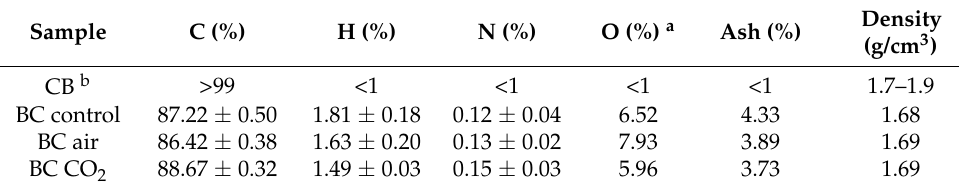
Table 2. Material properties of carbon black and biochar samples.